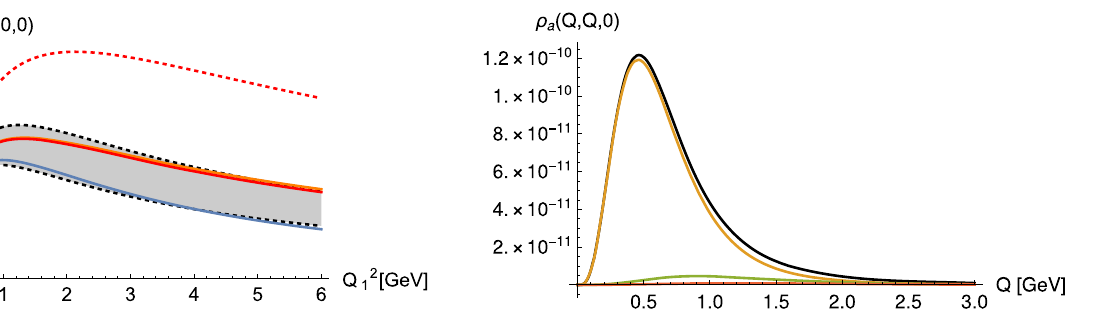
Fig. 10 The integrand ρ a ( Q 1 , Q 2 ,τ) in (8) in units of GeV − 2 for √ Q 1 = Q 2 and τ = 0 (implying Q 3 = 2 Q ) in case of the HW2 model. The black line is the result from the infinite sum over the tower of axial vector mesons, the other lines give the contributions of the 1st to 3rd lightest axial vector meson multiplets. (Figure taken from [38]) Table 2 Results in multiples of 10 − 11 for f π = 92 . 4MeV for the Sakai–Sugimoto model and the various chiral bottom-up models